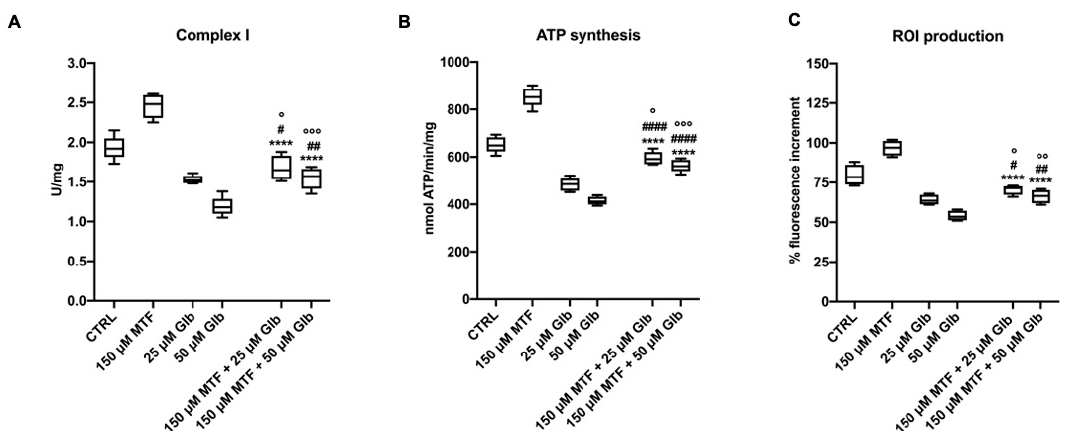
Figure 4. Effect of combination treatment with low doses of MTF and GLB on the aerobic metabolism and ROI production in rod OS. Figure reports the effect of the combination treatment compared with the single treatment. Treatments were: 150 µ M MTF + 25 µ M GLB and 150 µ M MTF + 50 µ M GLB. ( A ) Complex I activity, expressed as uU / mg of total protein. ( B ) ATP synthesis trough F o –F 1